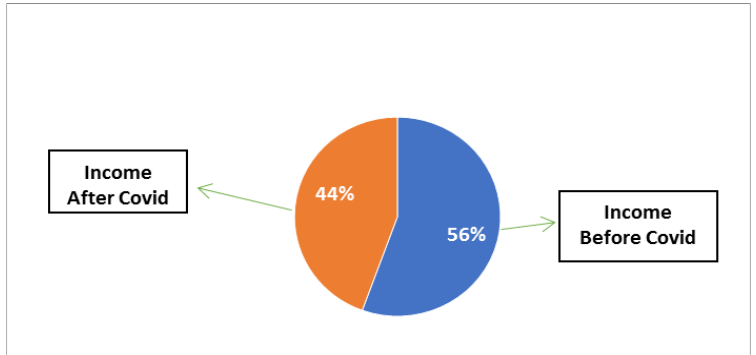
Figure 1: Percentage of Total Revenue for Sales before Covid-19 and After